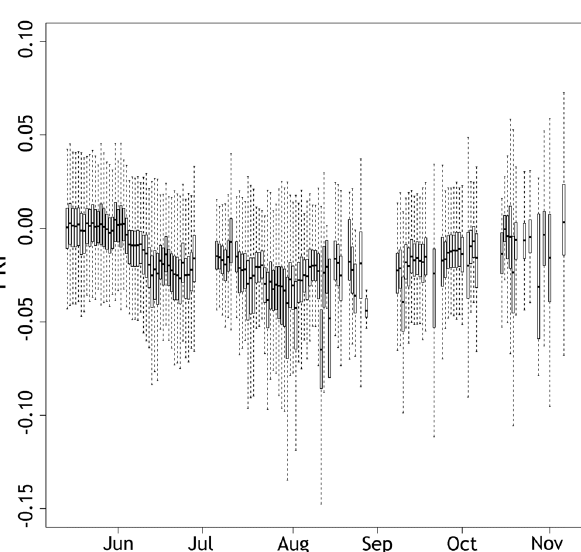
Figure 3. Boxplot of daily PRI distribution at the field site between May and November